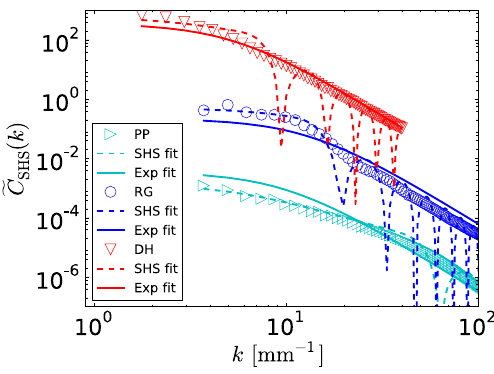
Figure 9. Comparison of the µ CT-derived e C(k) data to the SHS model (Eq. 34) and the exponential model (Eq. 38). To discern in- dividual curves, the RG and DH data were displaced vertically (by factors 10 2 , 10 4 ,